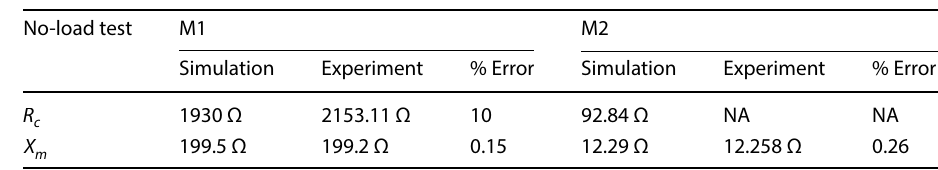
Table 5 Comparison of no-load test simulation result with experiment result